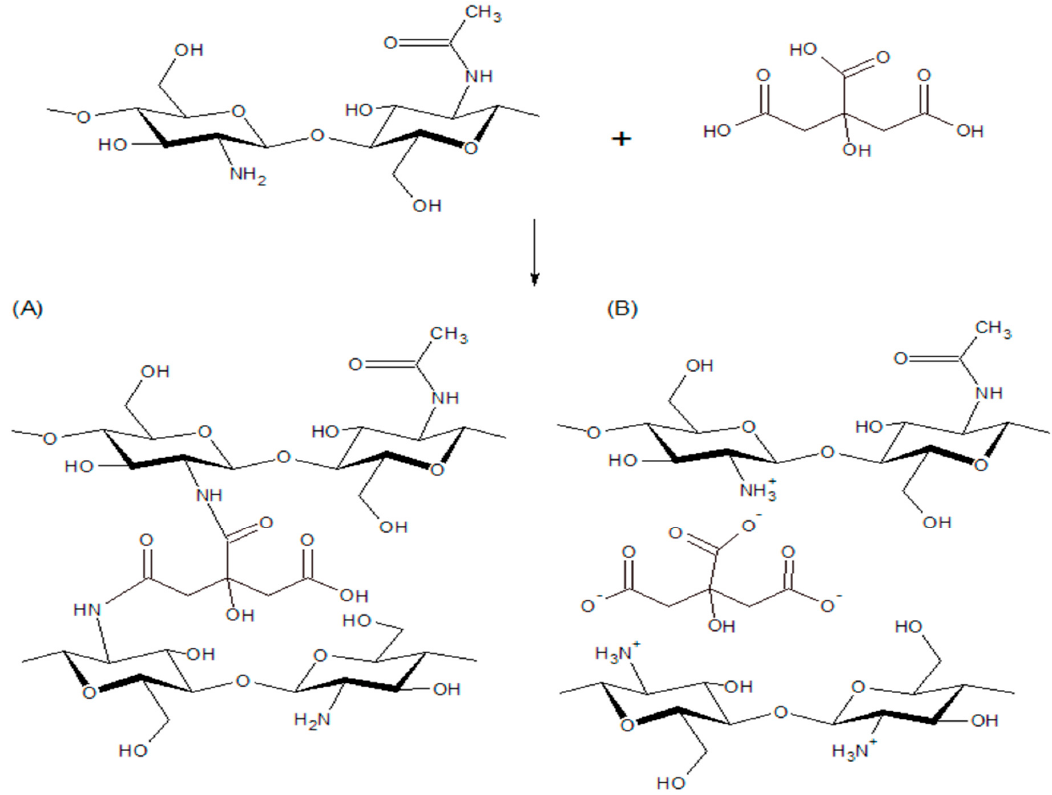
Figure 2. ( A ) Postulated covalent crosslinking of chitosan and citric acid with heat treatment and ( B ) electrostatic bonding and ionic crosslinking between the protonated amine and carboxylate ion of a non-heat treated chitosan citrate film.